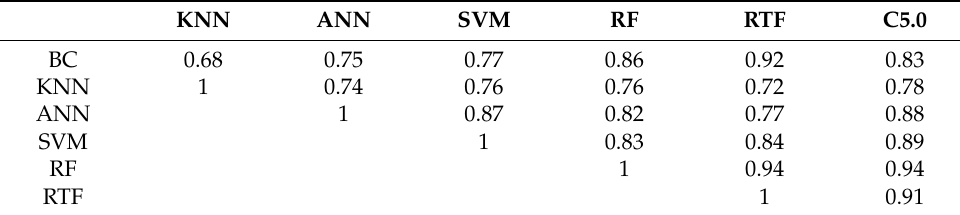
Table 6. Pearson’s correlation coefficient of the selected best-performing ML models.